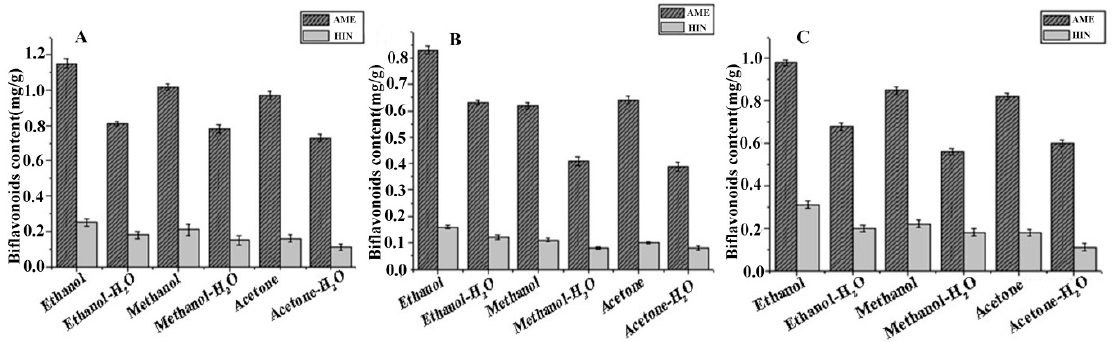
Figure 8. Comparison of different extractants in three conventional methods for extraction of AME and HIN from S. sinensis. ( A ) microwave extraction; ( B ) soxhlet extraction; ( C ) percolation extraction.